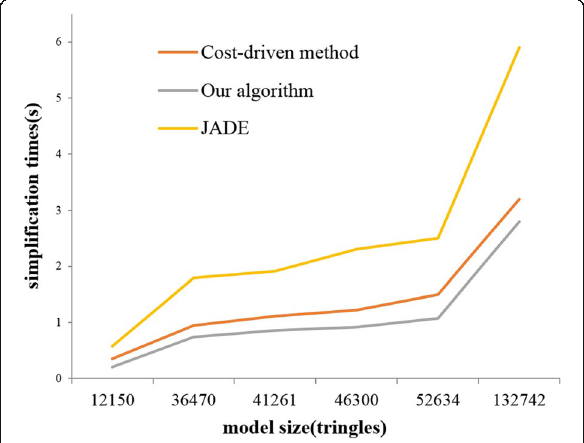
Fig. 10 Comparison of different simplification